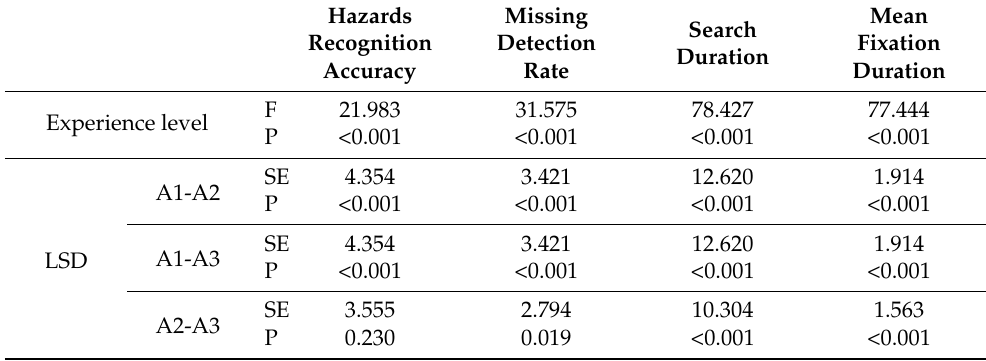
Table 6. Comparison of differences in hazard recognition results among three groups of workers.